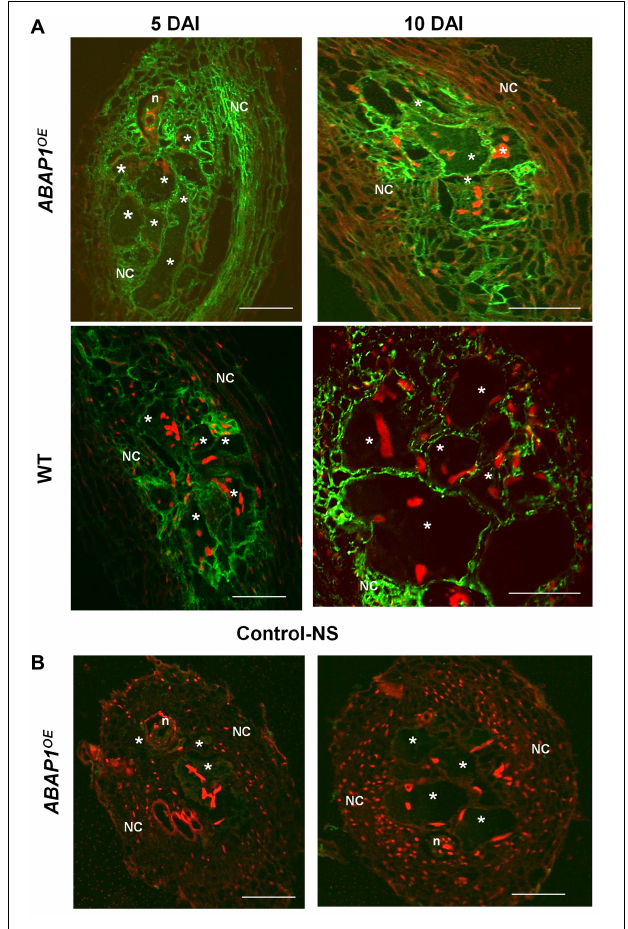
FIGURE 2 | Expression pattern of the Arabidopsis ABAP1pro:GUS line in uninfected roots and in M. incognita -induced galls. (A,B) Illustrate ABAP1 promoter activity in the root apical meristem (RAM), in an uninfected root (UR) and during gall development (3, 5, 7, 10, 14, and 21 days after inoculation). Bright-field images of whole roots and galls illustrate the GUS staining in blue (A) and dark-field images show GUS staining in red (B) . G, gall; Asterisk, giant cell; NC, neighboring cells; n, nematode. Scale bars = 50 µ m.